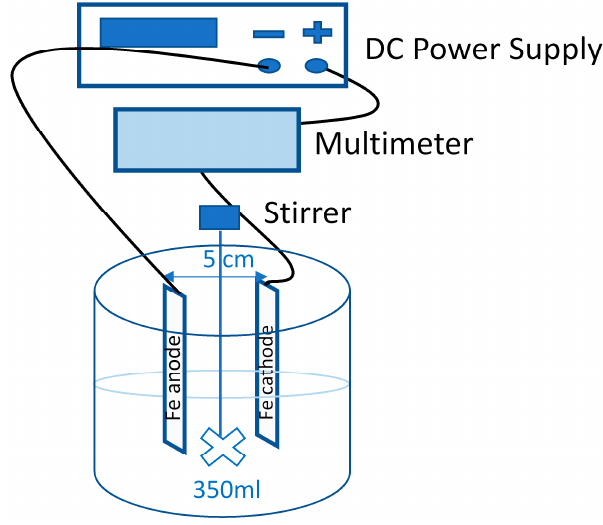
Figure 1. Scheme of the experimental arrangement.